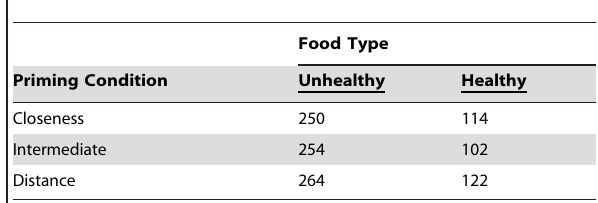
Table 2. Mean calorie estimates (computed across items) of the median ratings (computed across the subjects assigned to each condition) for the unhealthy and healthy